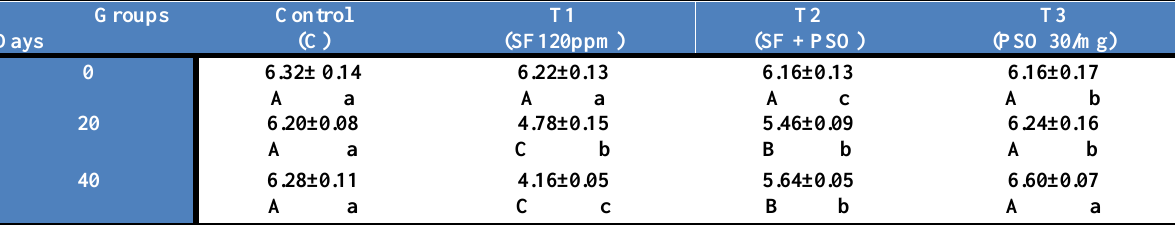
Table, 1: Effect of pomegranate seed oil (PSO) on total serum protein concentration (mg/dl) in female rats treated with sodium fluoride (SF).